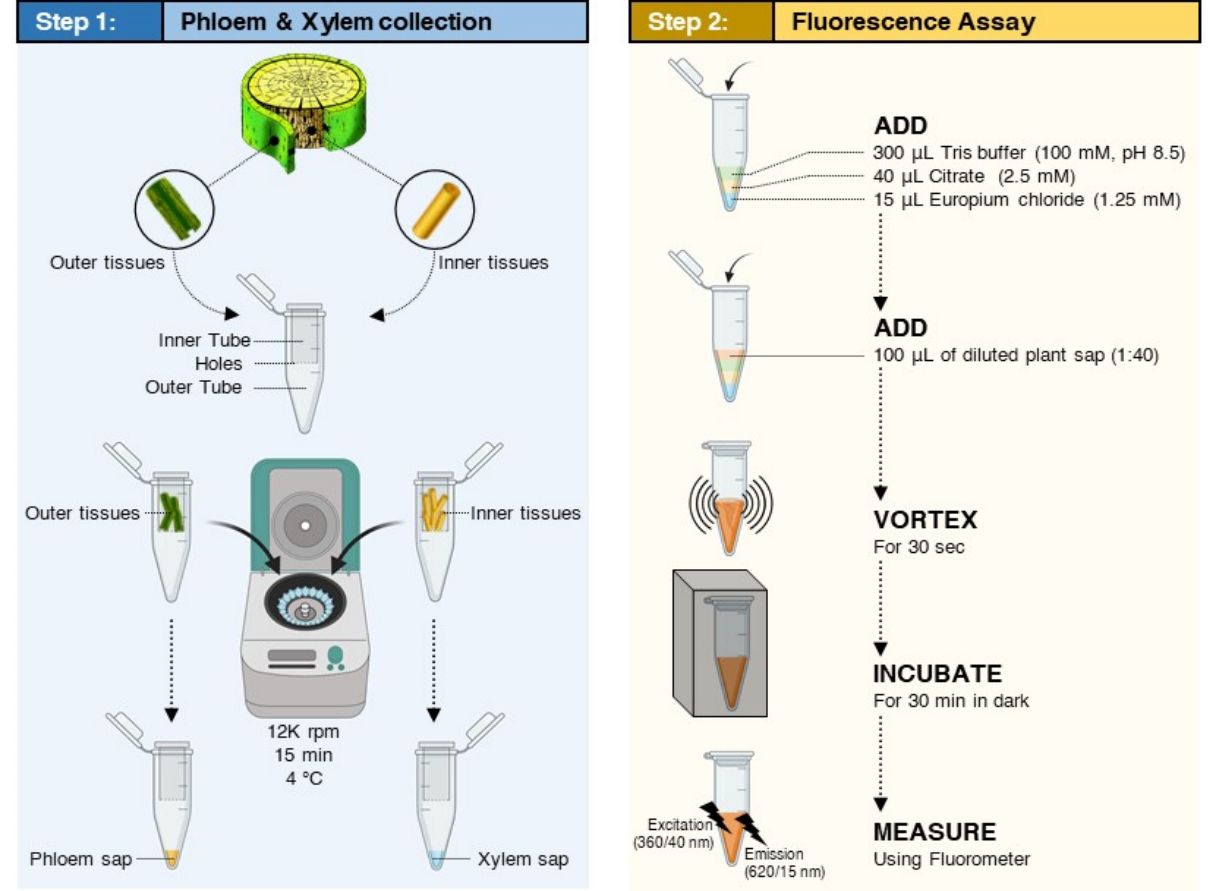
Figure 7. Flow chart of the determination of OTC in citrus sap phloem and xylem sap (directly without using SPE). Step 1 : Collection of citrus phloem and xylem saps by centrifugation. Step 2 : Determination of OTC using the fluorescence assay by mixing diluted saps (1 to 40) with Eu and citrate reagents in Tris buffer (100 mM, pH 8.5).